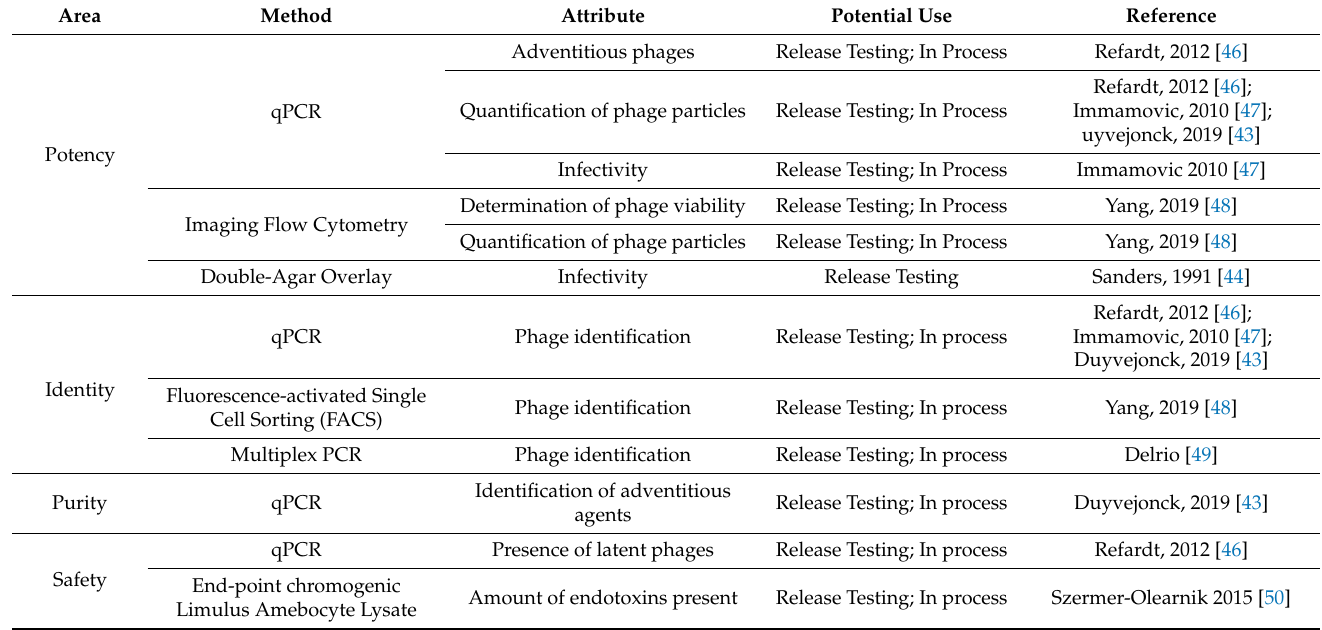
Table 3. Methods that can be used to evaluate product attributes for purposes of release testing as well as in process control